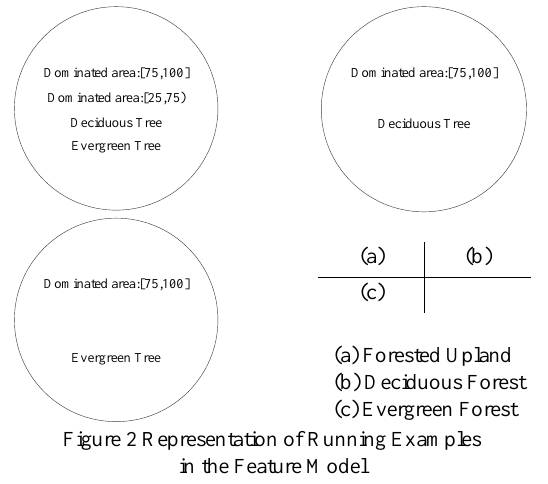
Figure 2 Representation of Running Examples in the Feature Model